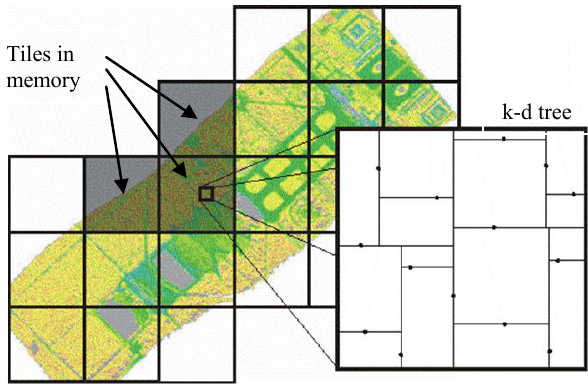
Figure 3. Two level point index structure of the ODM